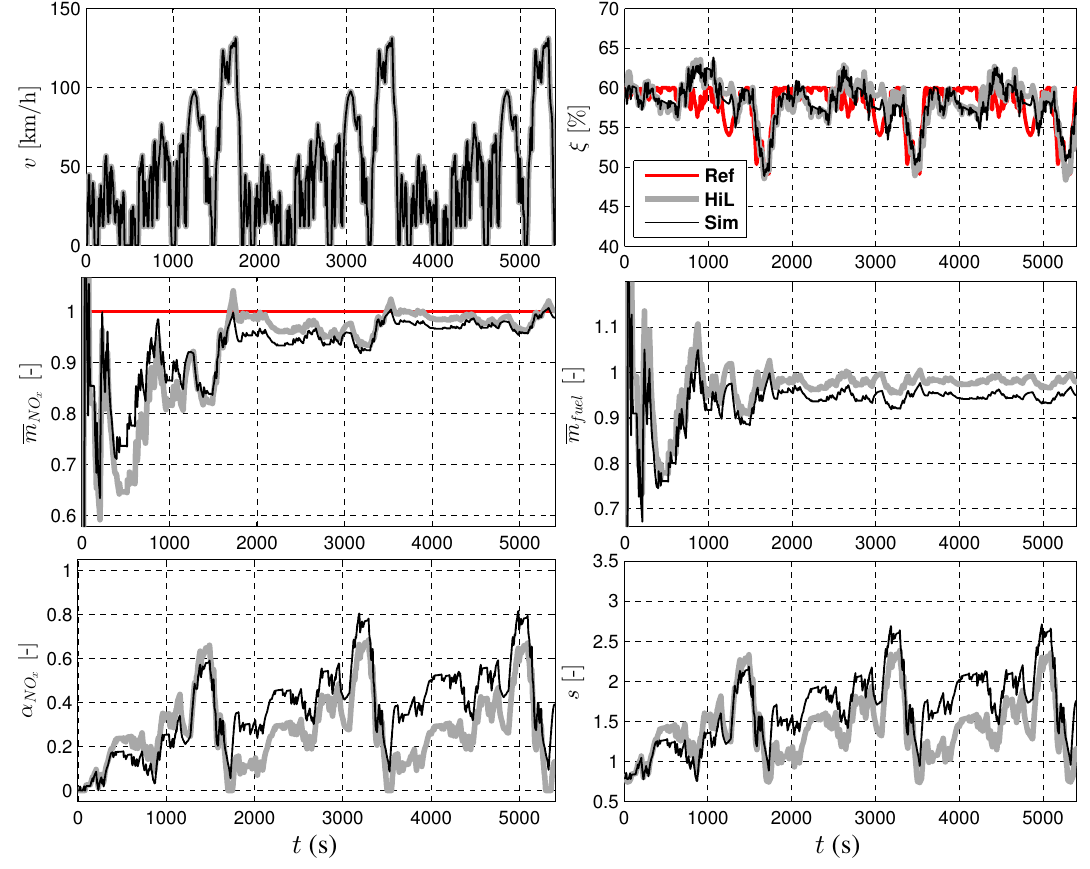
Figure 7. Comparison of results obtained with the simulation and with the hardware-in-the-loop (HIL) experiment on three repetitions of the Worldwide Harmonized Light Vehicles Test Procedure